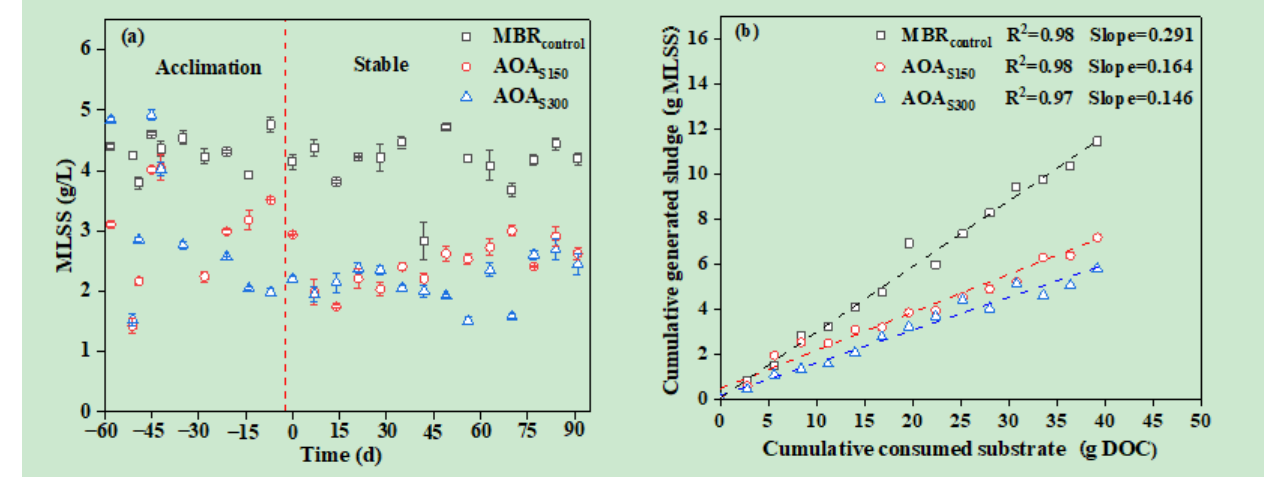
Figure 2. Change in the average MLSS concentration between acclimation and stable operation phases ( a ) and ( b ) the observed sludge yield (Y obs ) in the MBR control , AOA S150 , and AOA S300 biore-